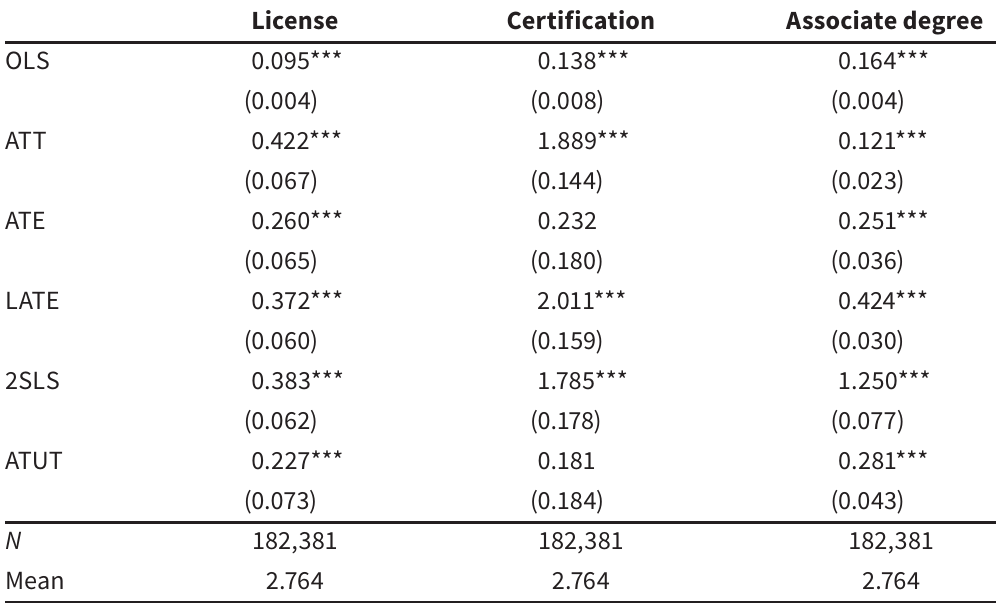
Table A3 Comparison of log wage returns to associate degree using our instrumental variable to returns to certification and licenses for the sub-baccalaureate population License